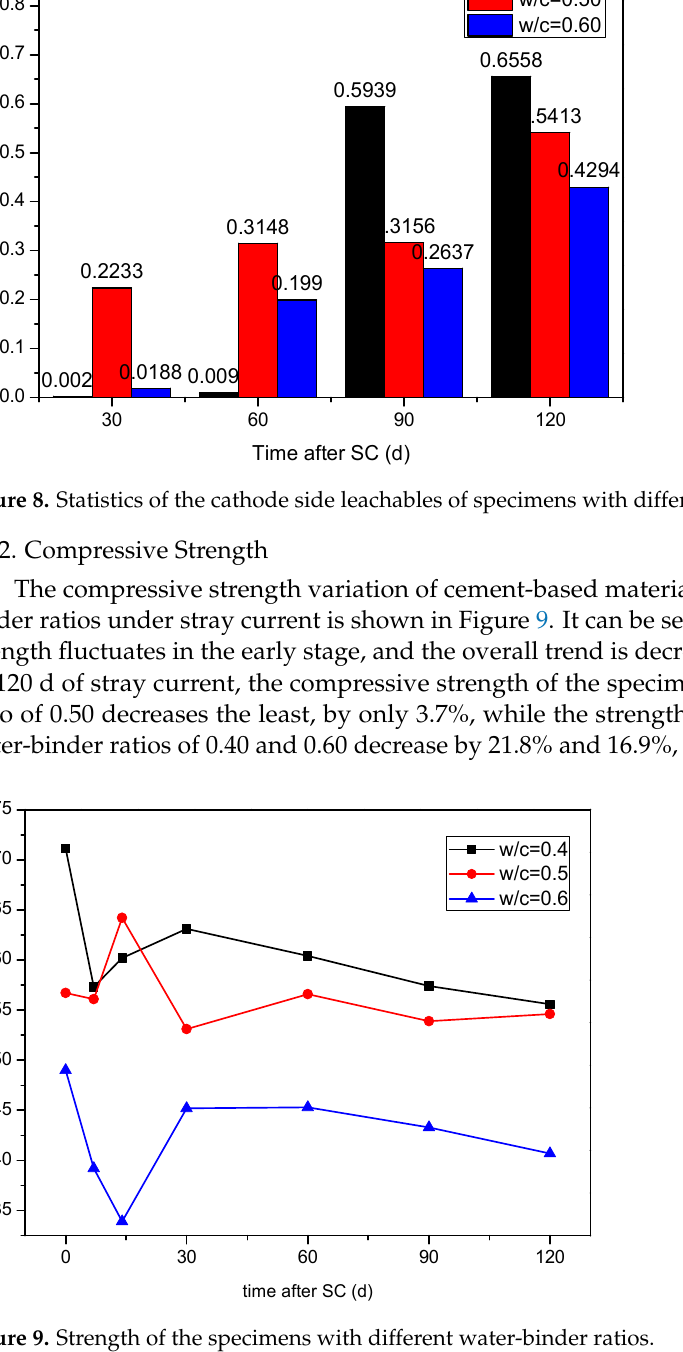
Figure 9. Strength of the specimens with different water-binder ratios.